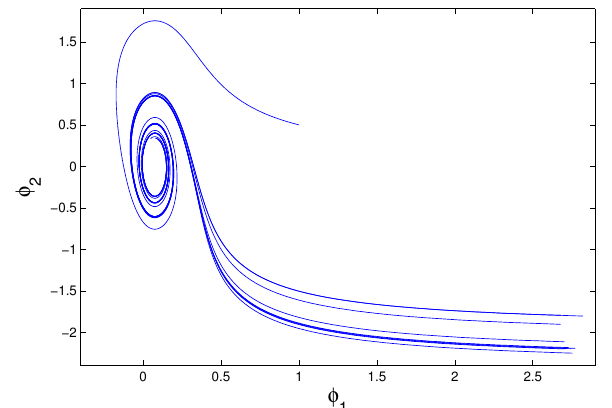
Figure 3. The trajectory of the solution φ ( t ) , which approximates the discontinuous unpredictable solution x ( t )